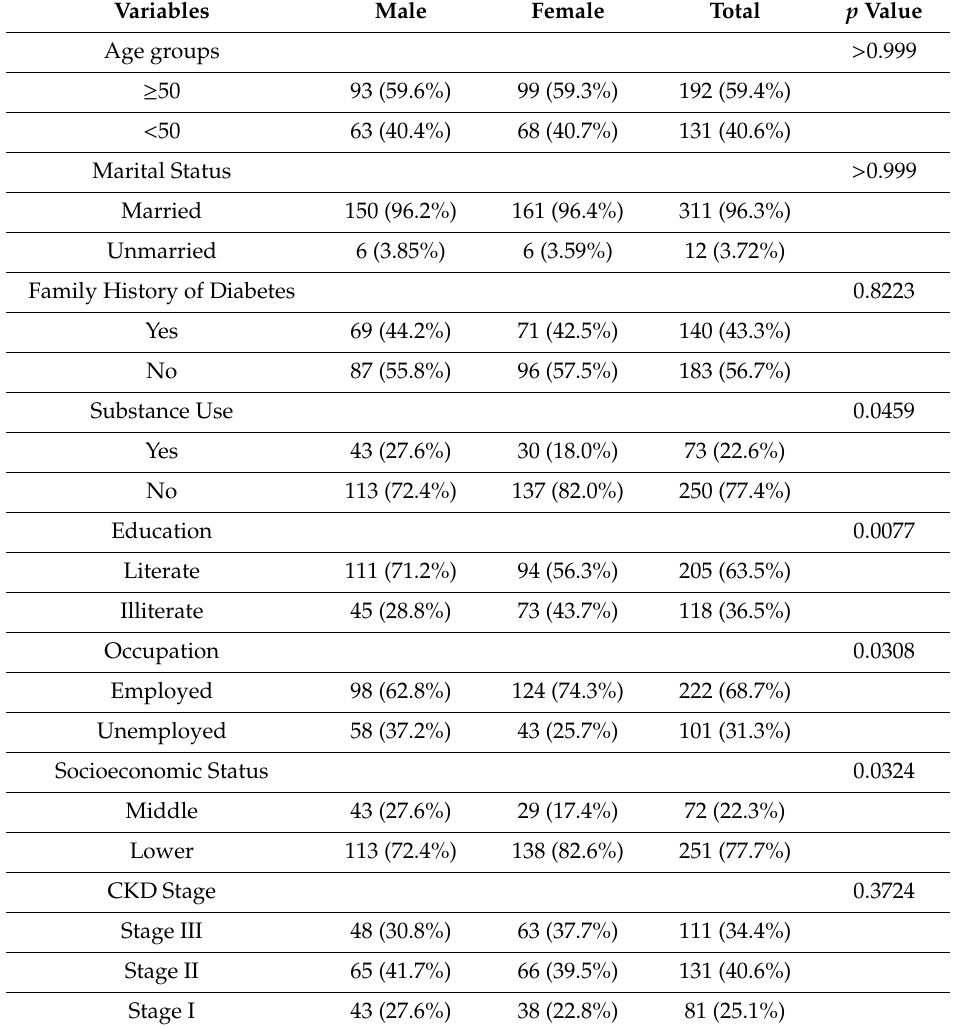
Table 1. Background characteristics of the